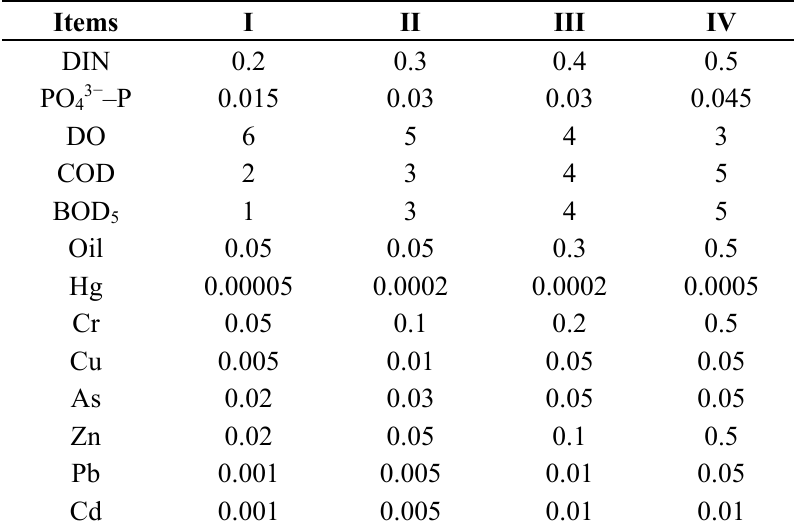
Table 1. The standard of seawater quality